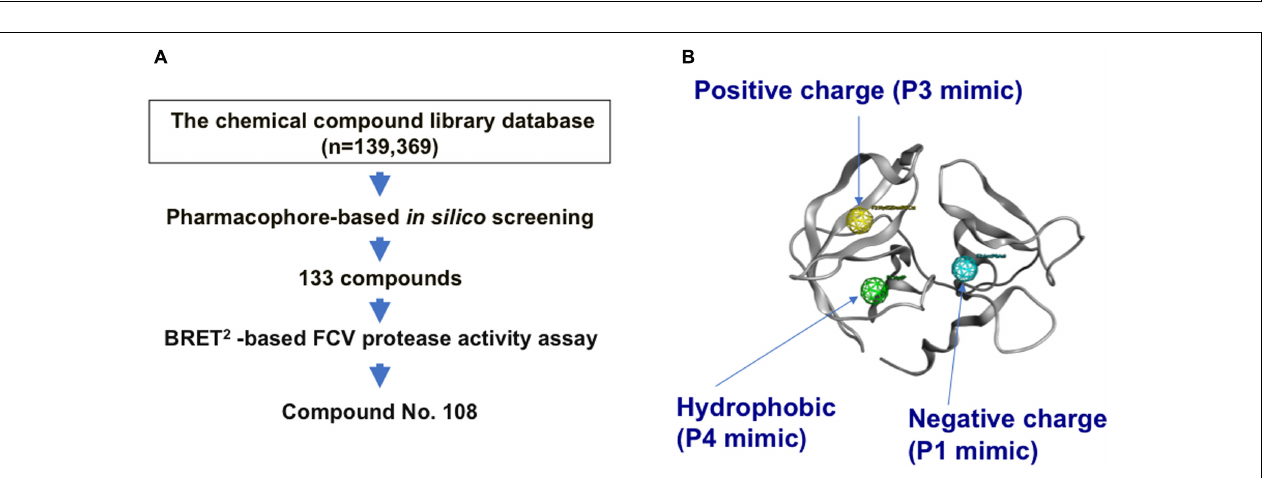
FIGURE 1 | Cleavage map of FCV precursor proteins and sequences around cleavage sites. (A) Cleavage map of the precursor proteins of the FCV. Red arrows illustrate the locations of five cleavage sites in ORF1 and a single cleavage site in ORF2 (Sosnovtsev et al., 2002). The map is based on the RNA genome information of the FCV F4 strain (Oshikamo et al., 1994). (B) Amino acid sequences around cleavage sites. The P4–P4 (cid:48) sequences of the six cleavage sites are indicated by a single letter code. A red arrow shows the cleavage site. The octapeptide used in this study is underlined.